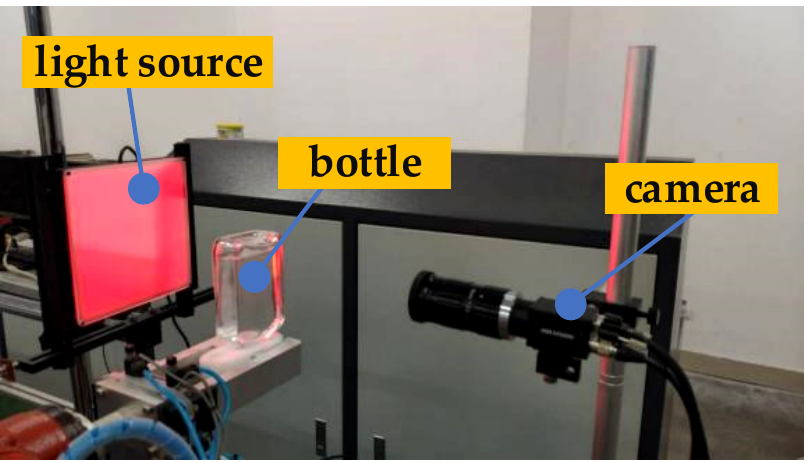
Figure 11. The position relationship between the light source, the camera and the bottle. To avoid inputting useless information to the detection system, such as bottle walls, background instruments and caps, a histogram projection of the binary image was calcu- lated. According to the projection result, the image ROI was cropped by positioning the histogram peaks. The process is shown in Figure 12 where the yellow part of the figure is the impurity detection region.